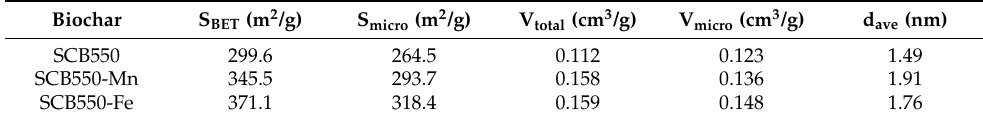
Table 2. BET surface area, pore volume, and pore size of pristine and catalytic biochars. Biochar S BET (m 2